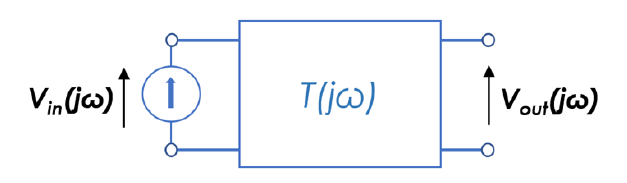
FIGURE 1. Black box diagram with VTF.